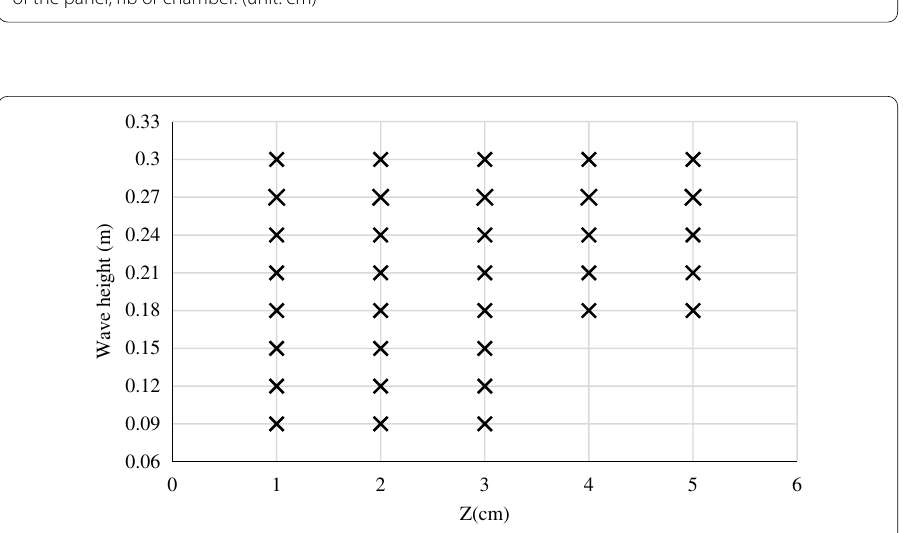
Fig. 9 Solitary wave height and clearance pairs in the cases in this